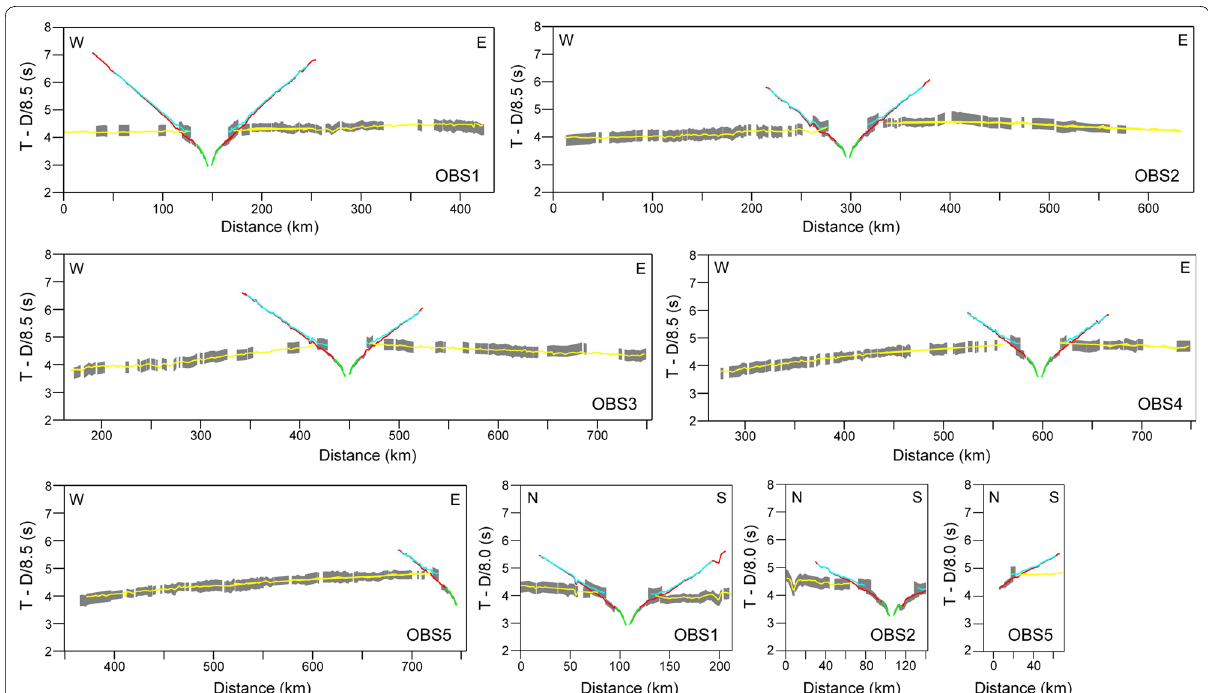
Fig. 7 Observed arrivals and calculated travel times for all OBSs. Vertical bars indicate the uncertainty of the observed arrivals. Reduction velocity is 8.5 and 8.0 km/s along the EW line and the NS lines, respectively. The colors of the calculated travel time curves are explained in Fig. 6